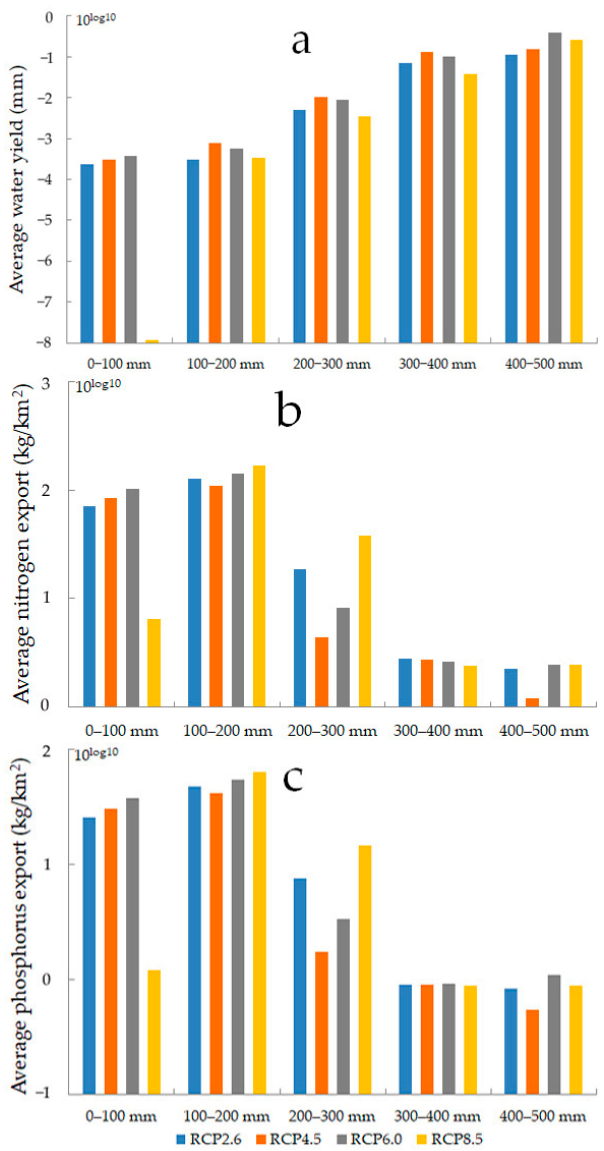
Figure 9. Average water yield ( a ), average nitrogen export ( b ) and average phosphorus export ( c ) of different precipitation in 2050 for RCP scenarios.